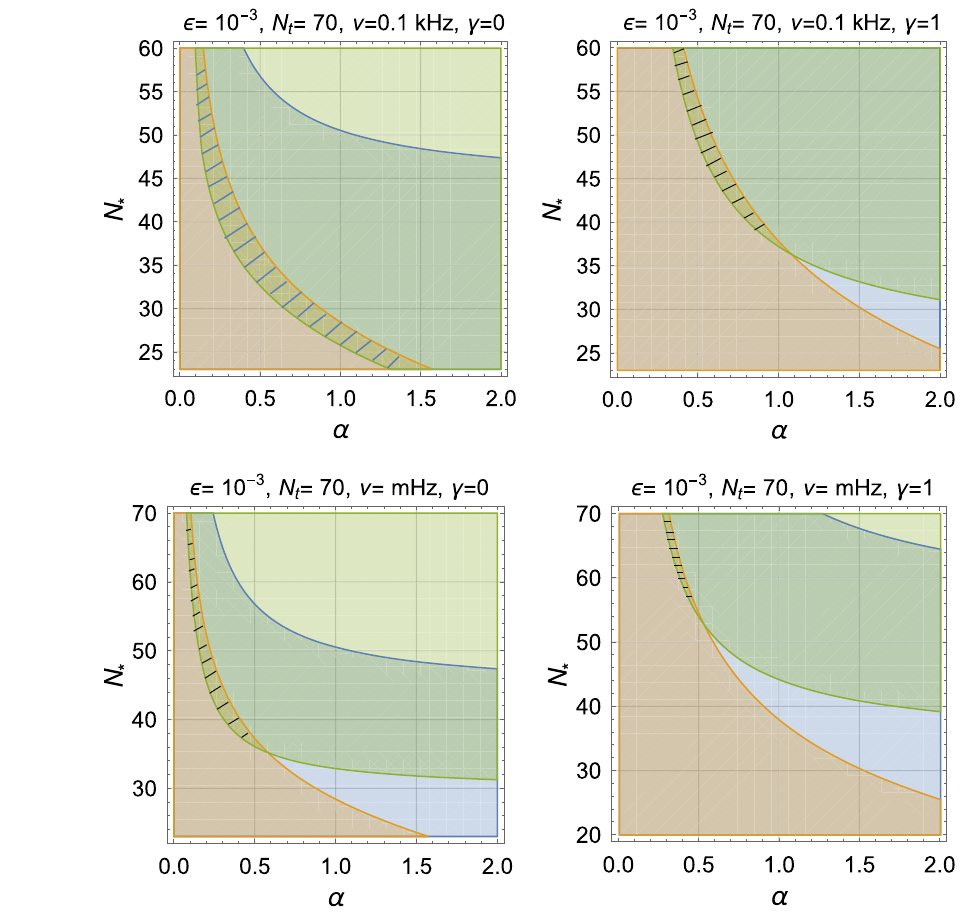
phenomenological bounds are satisfied and the spectral energy density (in critical units) exceeds 10 − 12 at the centre of the mHz band in the cases γ = 0 (left plot) and γ = 1 (right plot). The dashed areas denote the regions of the parameter space where the three constraints are simultaneously satisfied. Figures 7 and 8 pin down the two complementary portions of the parameter space: by comparison we can see that the dashed areas of Figs. 7 and 8 do